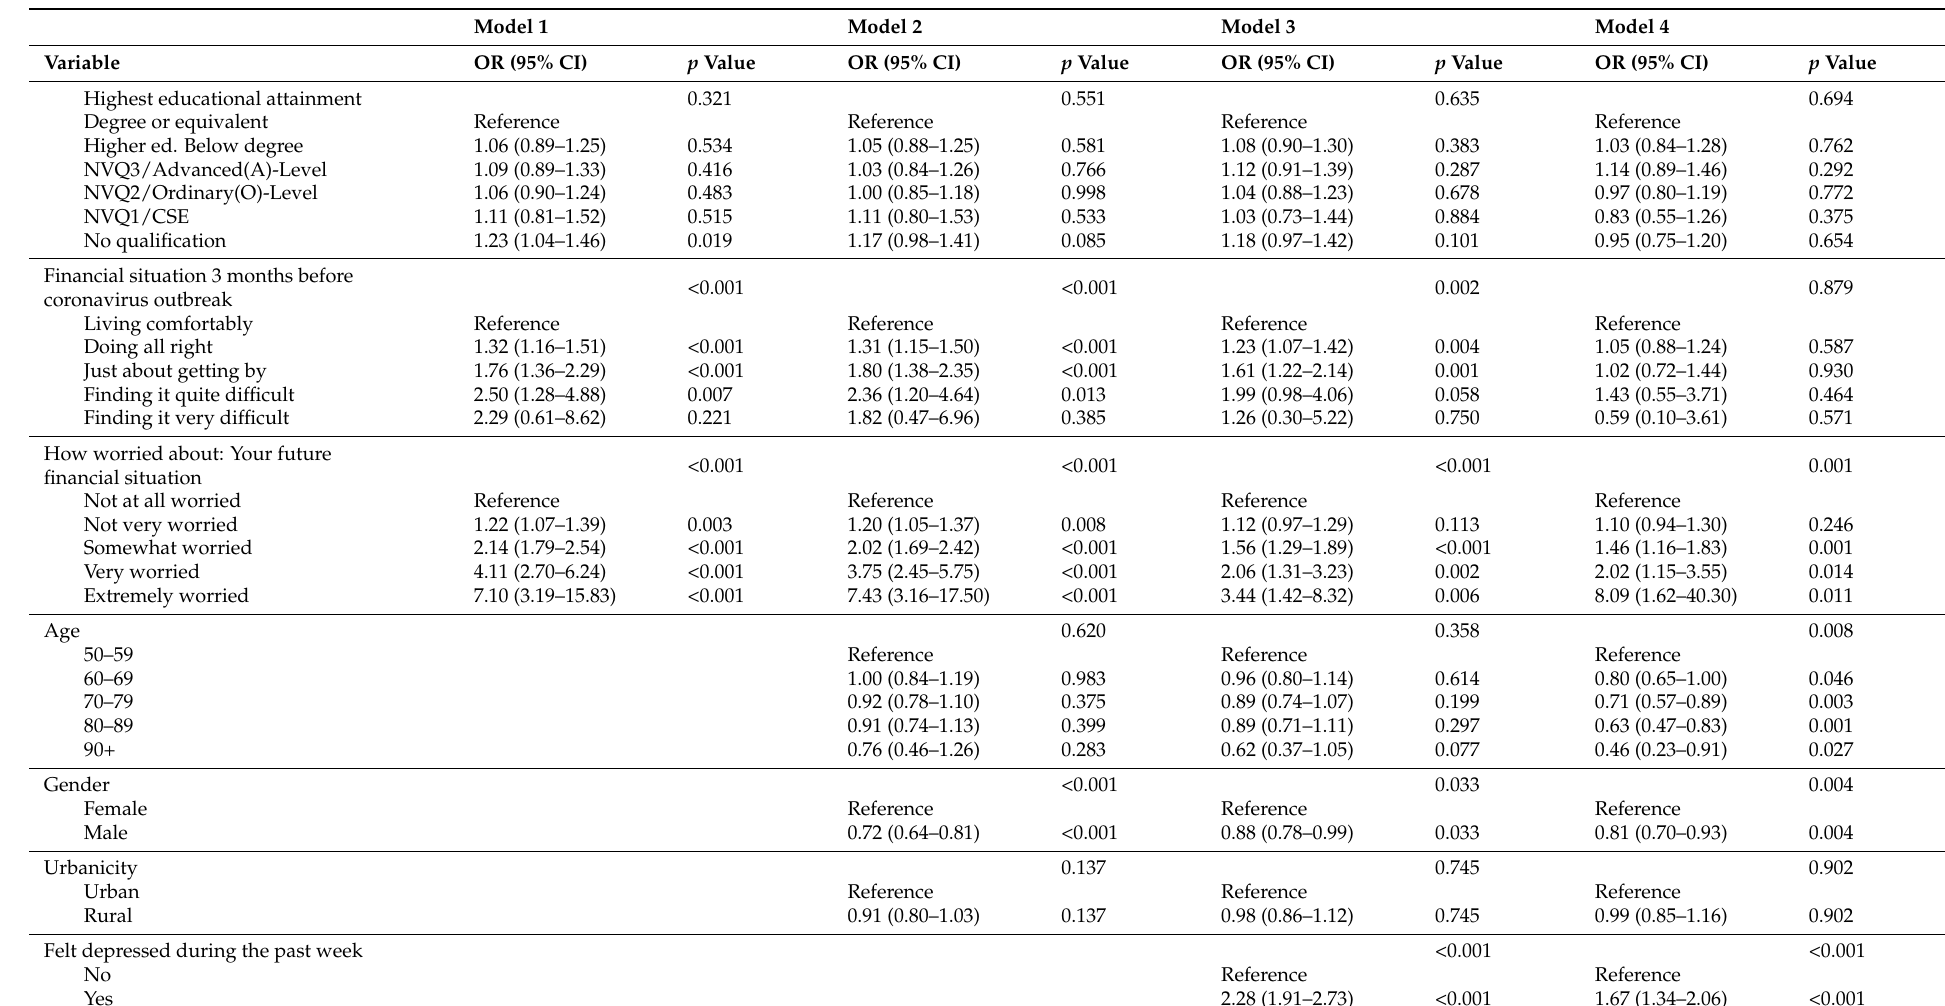
Table 3. Results of Logistic Regression